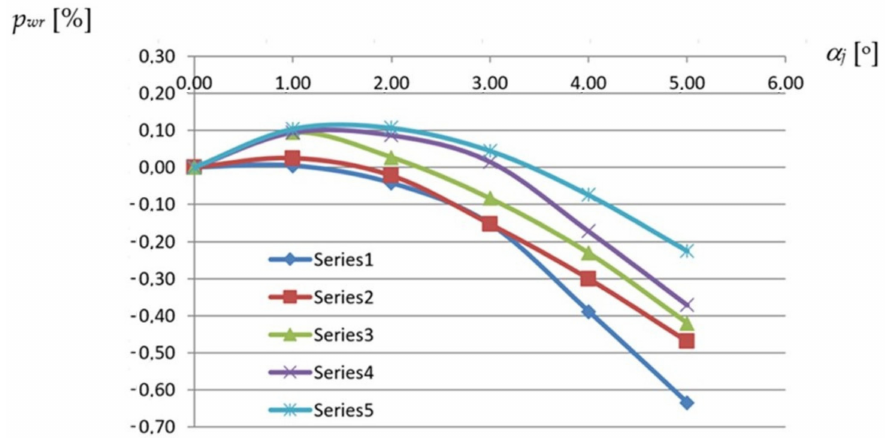
Figure 20. Nonlinear relations between the relative p wr increments of the surface area and the unit twist angle α j of a shell fold supported by two straight directrices obtained for various profiles: Series1—TR50 × 0.75 mm × 8.0 m; Series2—T55 × 0.88 mm × 6.2 m; Series3—TR85 × 0.75 mm × 5.0 m; Series4—TR136 × 0.88 mm × 6.0 m; Series5—T160 × 0.75 mm × 6.6